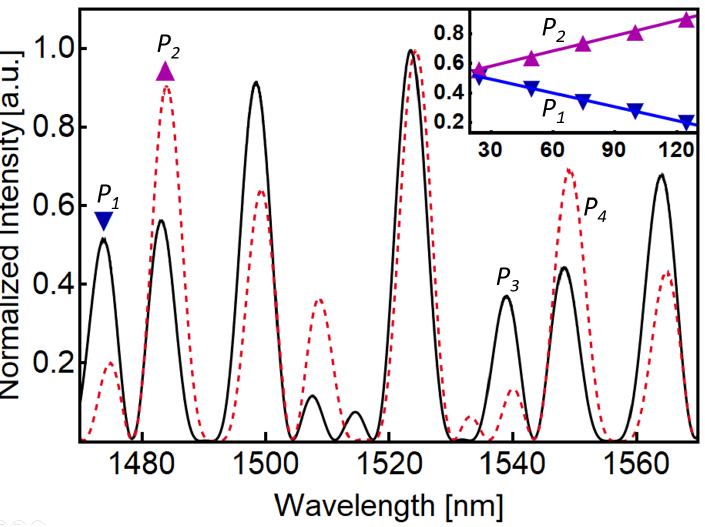
Figure 6. Experimental spectral response of the concatenated SMF-SCF-SMF devices when L 1 is at room temperature (black curve) and heated at 124 °C (dashed red curve). The inset shows the peak intensity of P 1 and P 2 as a function of temperature.